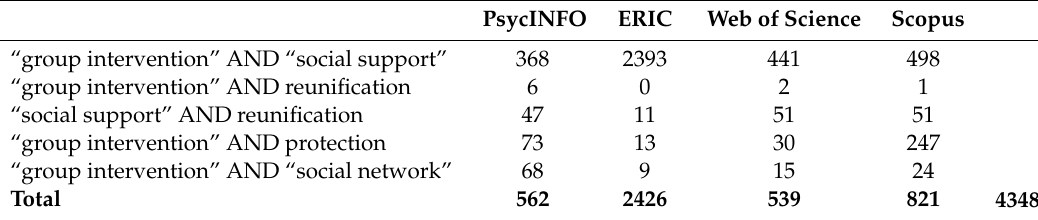
Table 1. Results of the